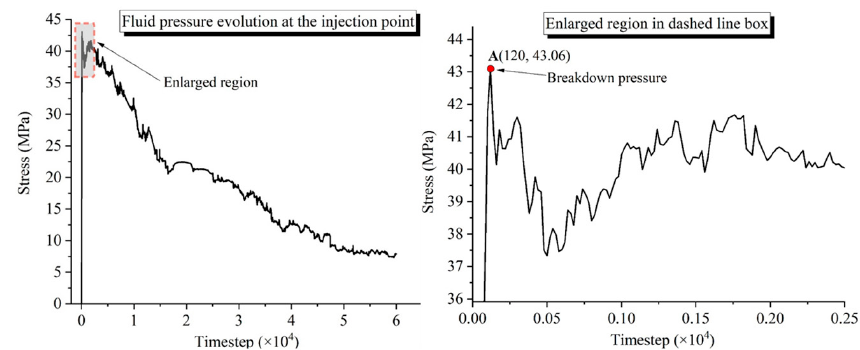
Figure 8. Evolution curve of fluid pressure–time–step at injection point.